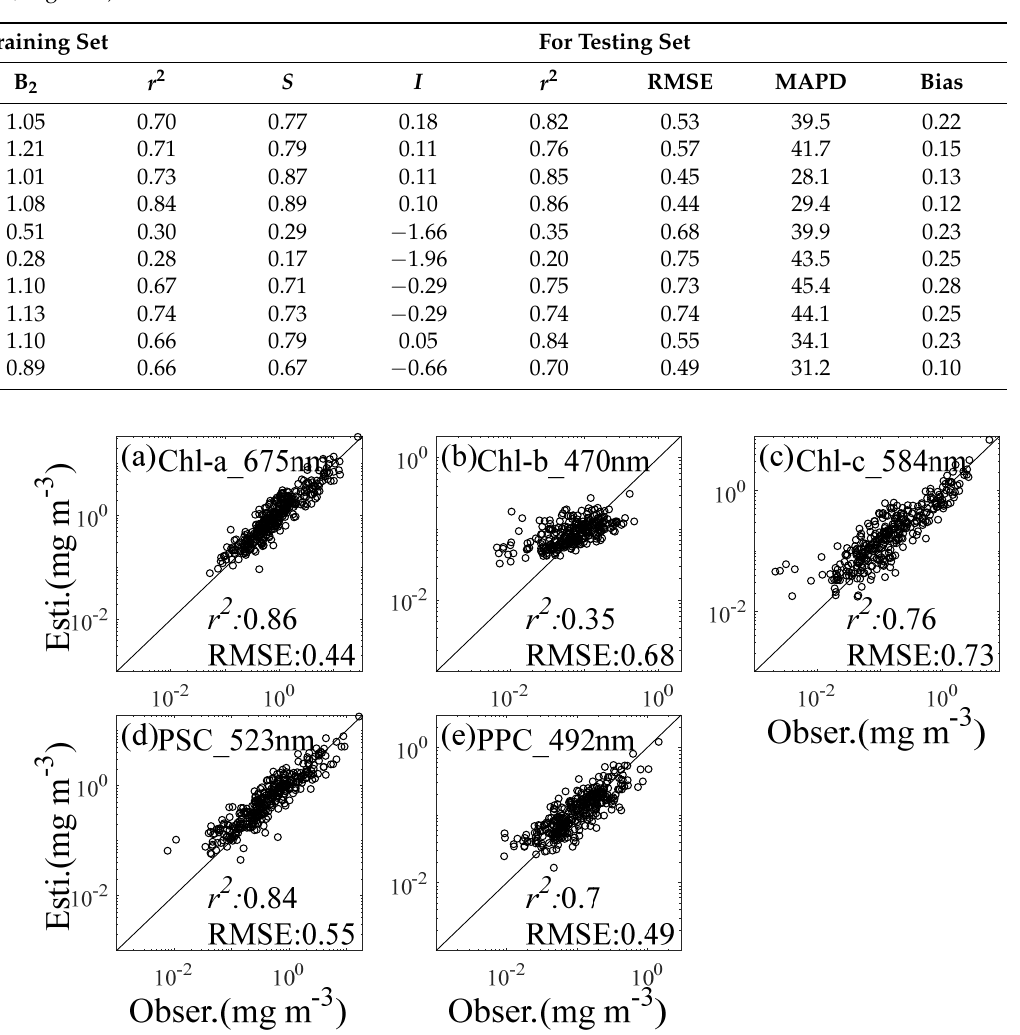
Table 4. Statistics for the Gaussian model including A 2 and B 2 for Equation (3), slope ( S ), intercept ( I ), and determination coefficient ( r 2 ) for the linear regression, root mean square error (RMSE, mg m − 3 ), median absolute percent difference (MAPD, %), and bias (Bias, mg m − 3 ).